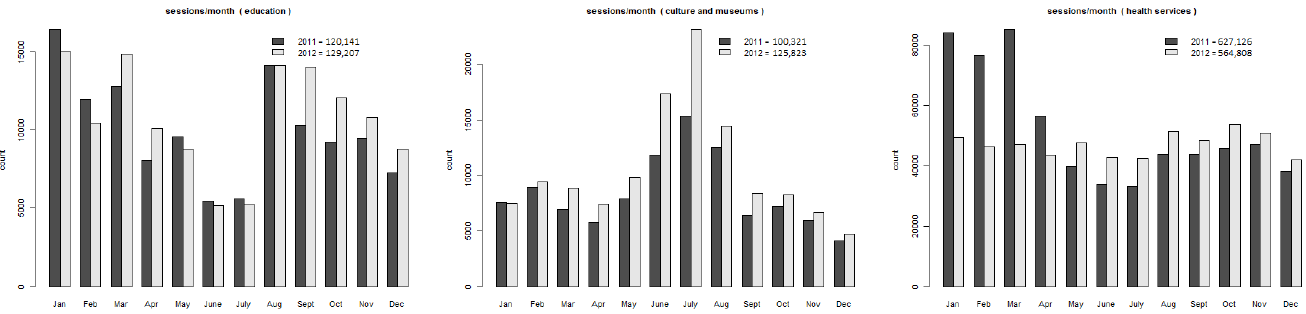
Figure 1. Typical visit patterns.